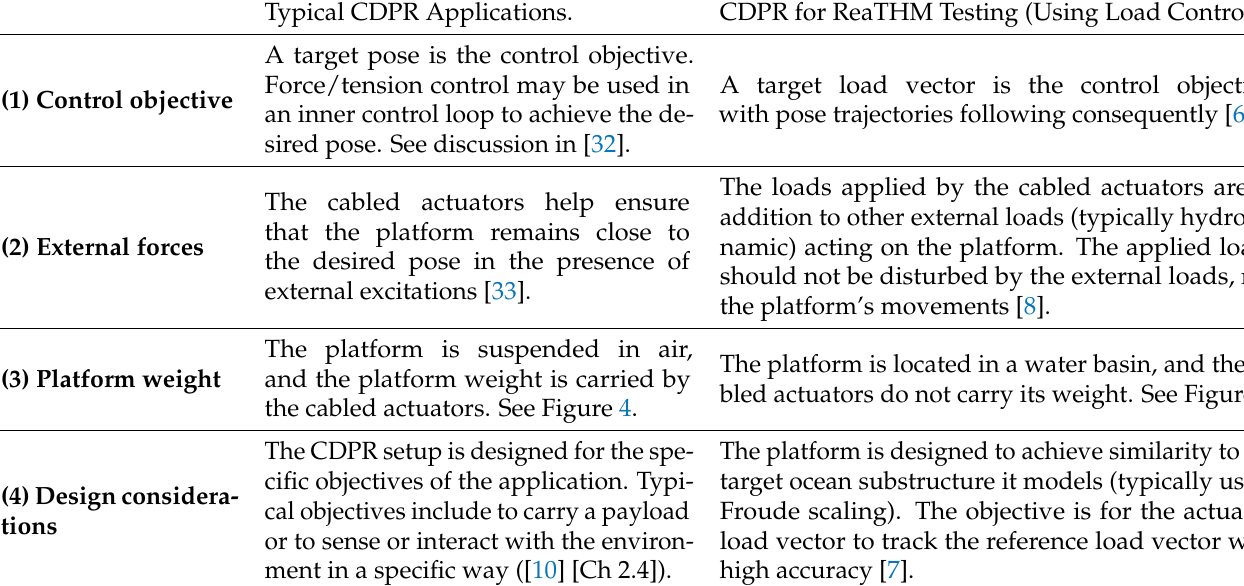
Table 1. Differences between CDPR in typical applications and CDPR in ReaTHM testing. Typical CDPR